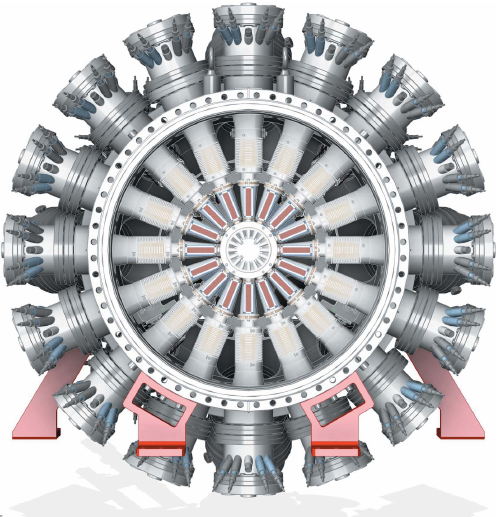
Figure 6 Axial view of the multi-resolution electron spectrometer array detector along the direction of X-ray propagation, showing the 16 azimuthal eToFs MRCOFFEE image taken from Walter et al. (2021).